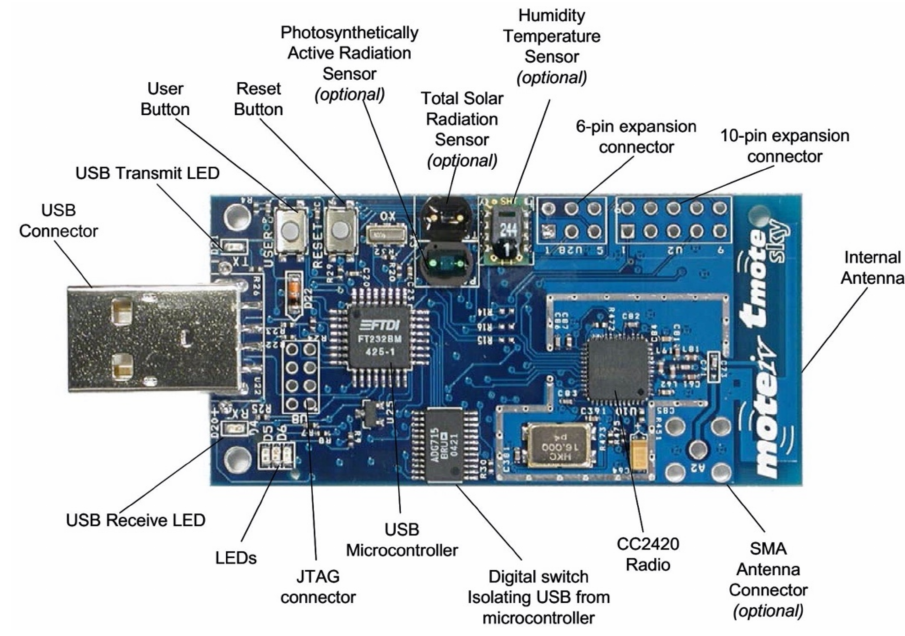
Figure 9. Pictorial description of CM5000-TelosB [164,168].